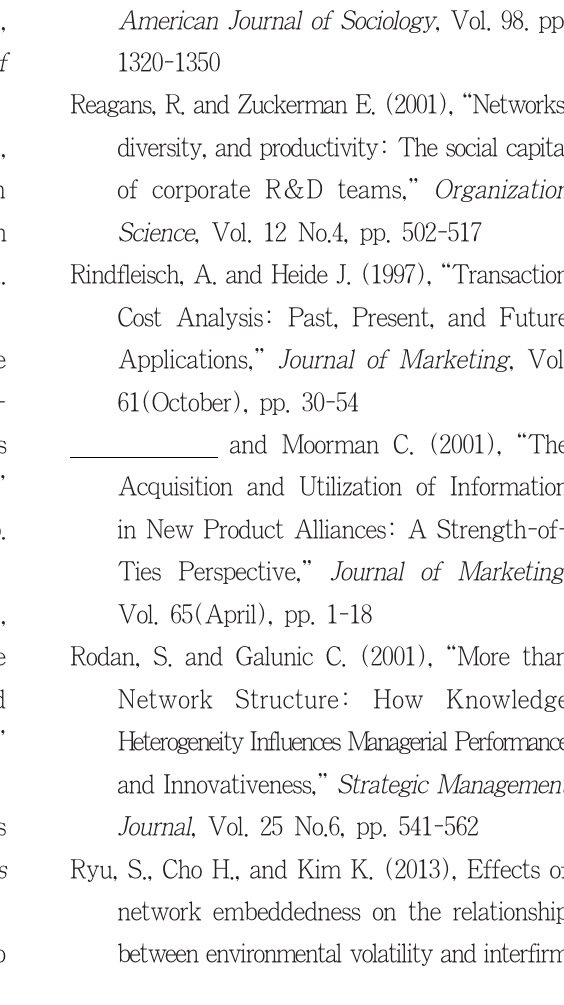
How Network Structure Impacts Firm Performance: The Moderating Effect of Network Openness and Interfirm Governance